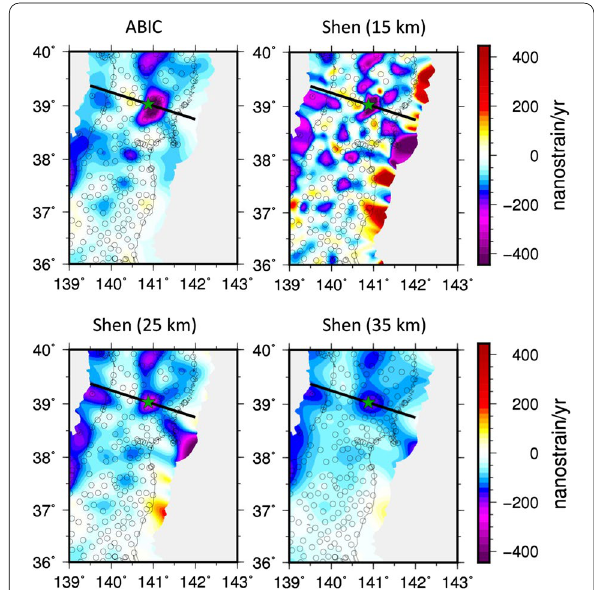
Fig. 5 Comparison of the estimated dilatation-rate fields in the Tohoku region. The location is indicated by box B in Fig. 2. Results of different D values are presented for Shen’s method. Green stars represent the epicenter of the 2008 Iwate-Miyagi inland earthquake. Black lines indicate the location of the cross section shown in Fig. 6c. Open circles represent the GNSS stations